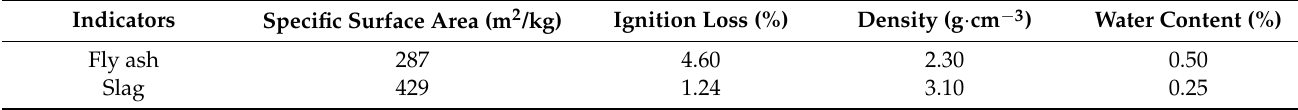
Table 2. The physical properties of fly ash and slag.